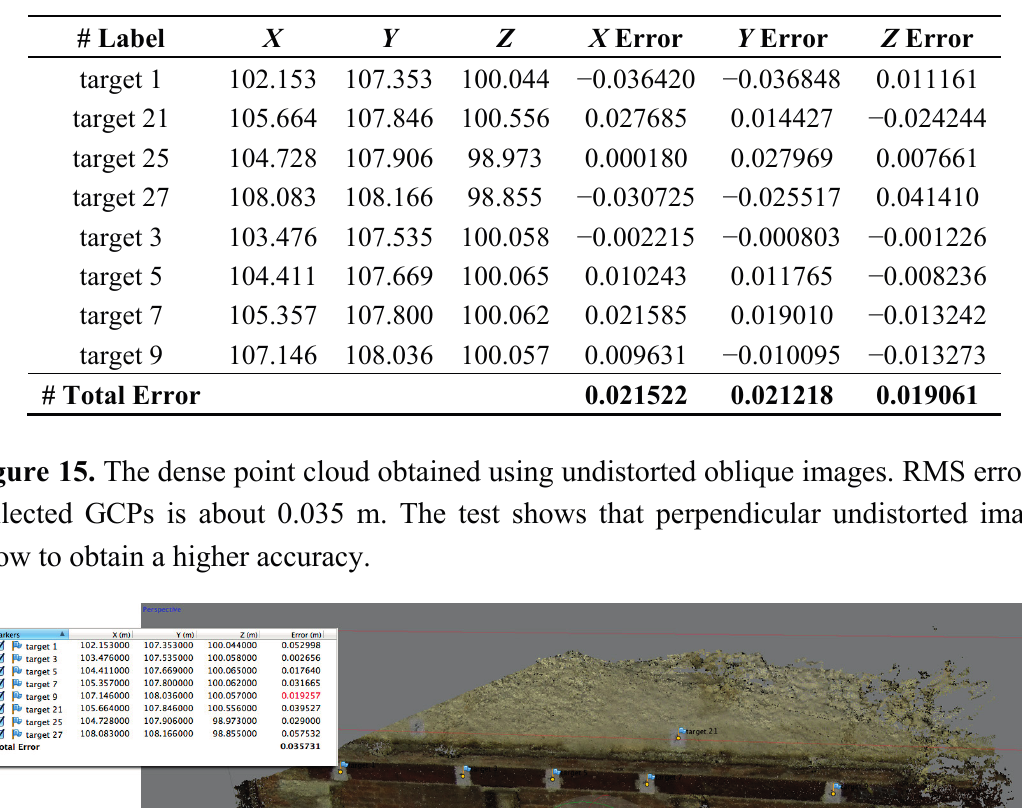
Table 6. Oblique undistorted strip errors.